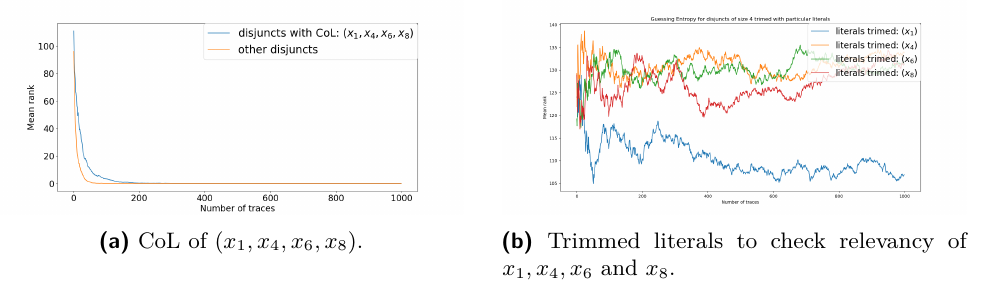
Figure 9: Guessing entropy of TTSCA small on simulated traces of masking order 3 ( d + 1-order